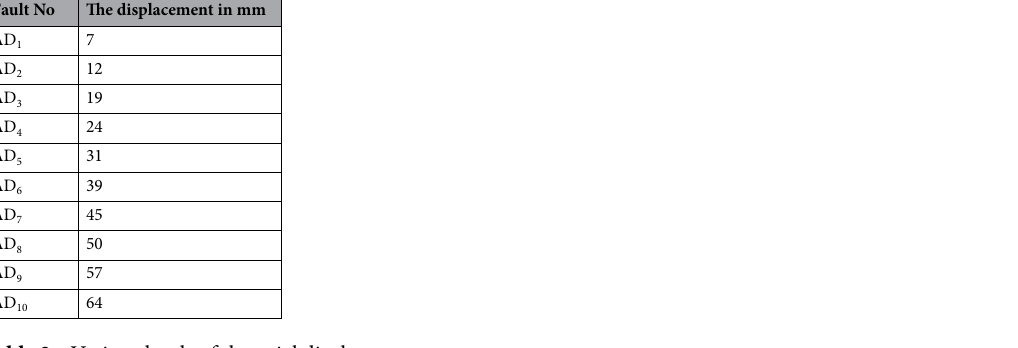
Table 2. Various levels of the axial displacement.